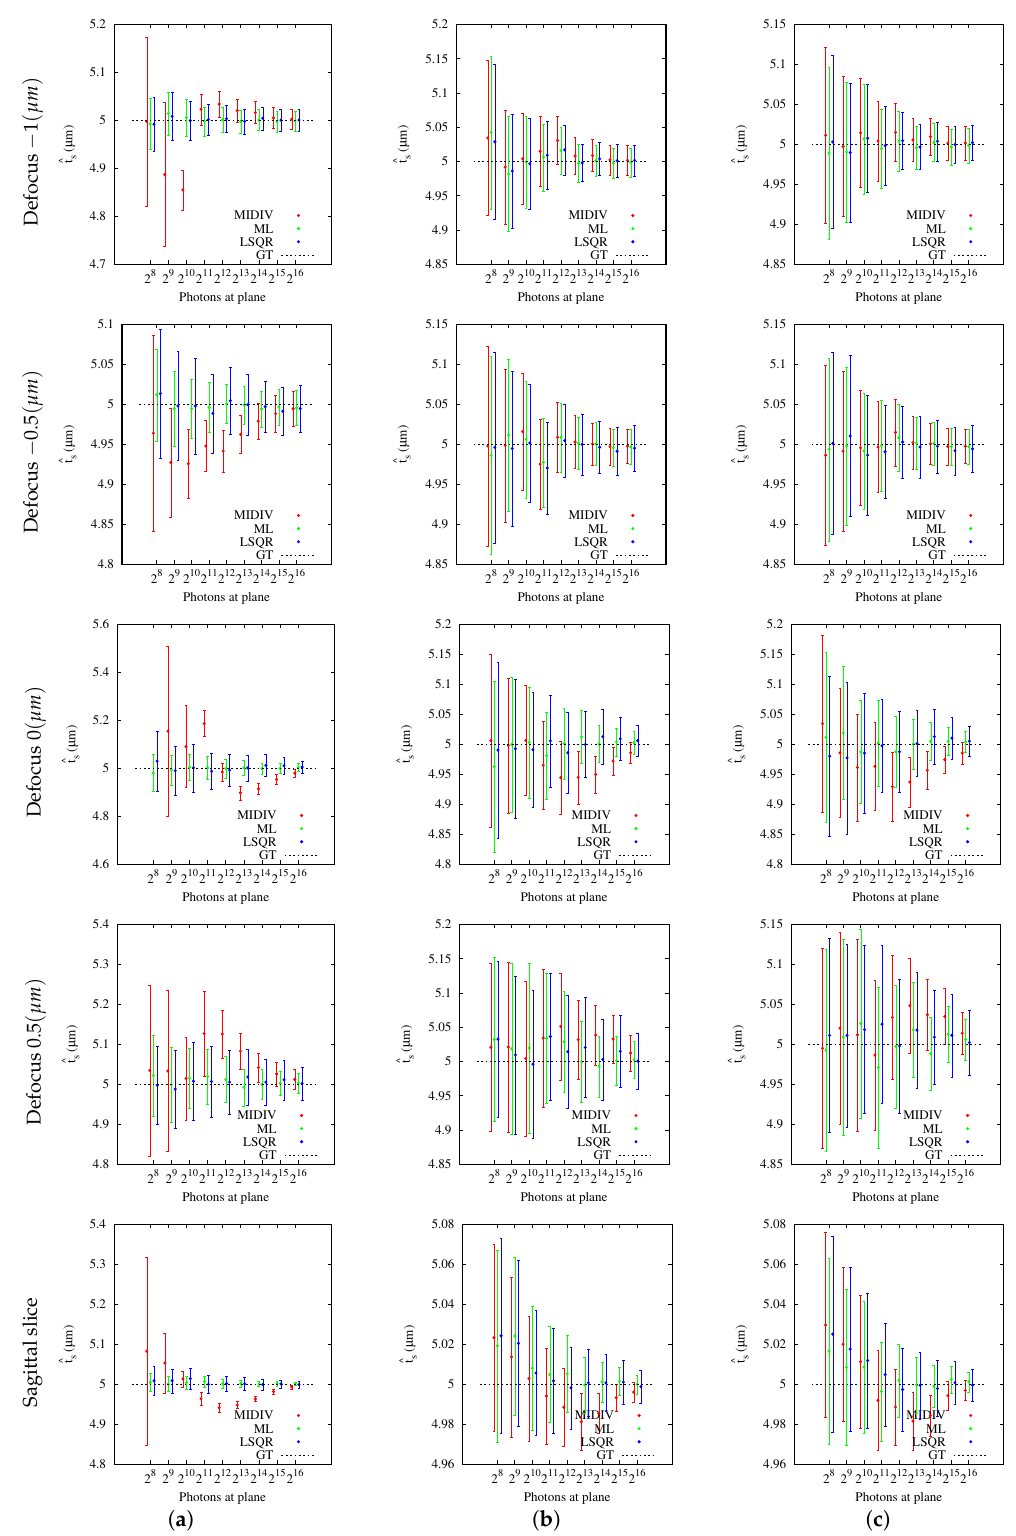
Figure 8. Accuracy measurements of methods: MIDIV (red), ML (green) and LSQR (blue). The dashed line at 5 µ m represents the ground truth (GT), the actual value of the parameter from which data were generated. The results of accuracy are presented as the mean point estimates of the set of estimations of t s and their confidence intervals. ( a ) NCI; ( b ) NCII; ( c )